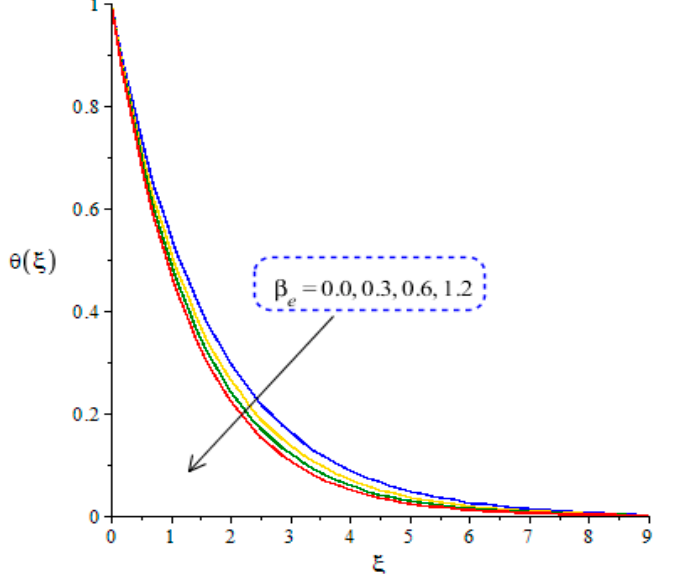
Figure 14. Variation role of θ ( ξ ) versus β e when m = 0.43, We = 5.0, Ω = 3.0, M 2 = 0.34, β i = 0.3, Figure 14. Variation role of 𝜃(𝜉) versus 𝛽 (cid:3032) when 𝑚 = 0.43, 𝑊𝑒 = 5.0, Ω = 3.0, 𝑀 (cid:2870) = 0.34, 𝛽 (cid:3036) = (cid:101) = 0.3, F r = 2.0, Pr = 204, Ec = 0.3, ϕ 2 = 0.0075, ϕ 1 = 0.002, ϕ 3 = 0.3, 𝜖 = 0.3, 𝐹 (cid:3045) = 2.0, 𝑃𝑟 = 204, 𝐸𝑐 = 0.3,𝜑 (cid:2870) = 0.0075, 𝜑 (cid:2869) = 0.002,𝜑 (cid:2871) = 0.005.